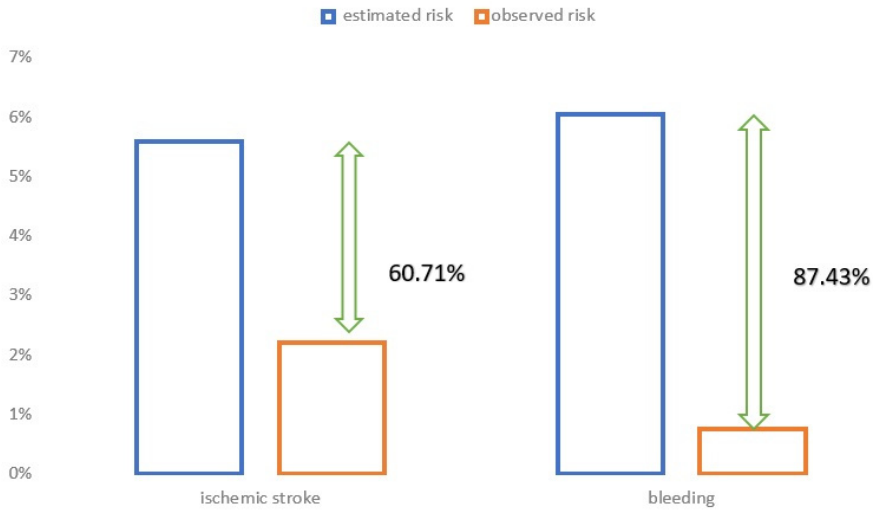
Figure 1. Comparison of observed versus estimated risk of ischemic stroke and bleeding complications in the studied population.